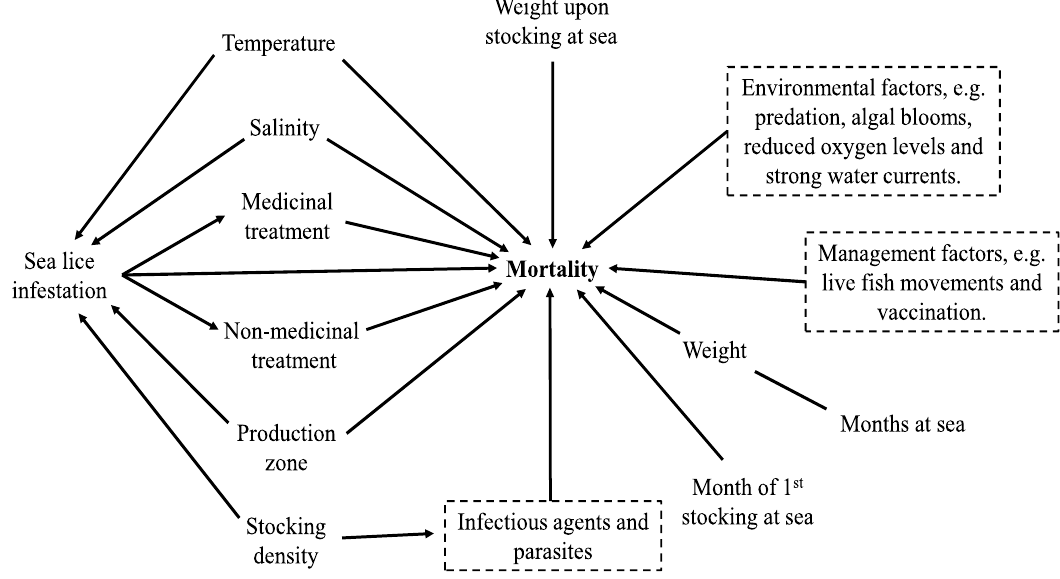
Figure 7. Directed acyclic graph (DAG) showing the putative determinants of baseline mortality in farmed Atlantic salmon. Dashed boxes represent unobserved